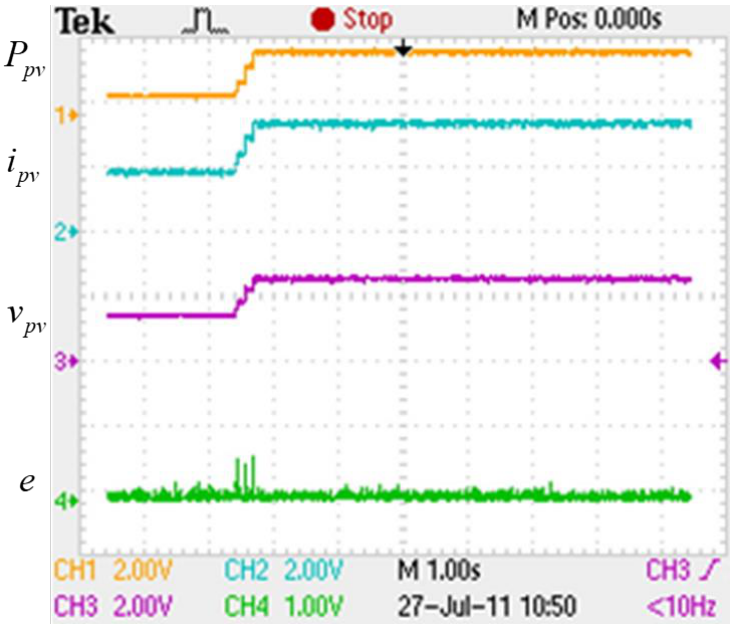
Figure 16. The output waveforms of the PV system at a certain solar irradiation.